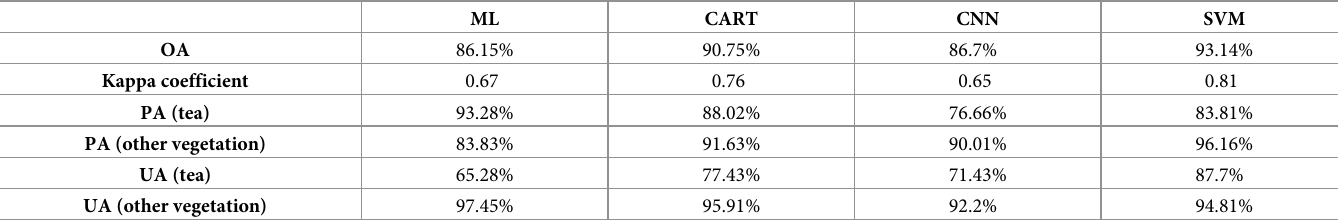
Table 6. Accuracy assessment of 2017 classification result (OA(Overall accuracy), PA(Producer accuracy), UA(User accuracy), ML(Maximum